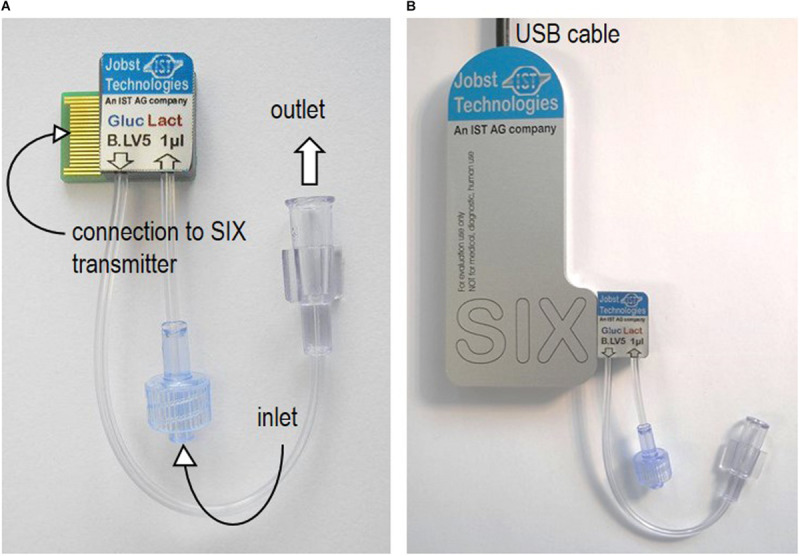
Biosensor platform. (A) The biosensor chip B.LV5 designed as a flow-through-cell with connection to the SIX transmitter and luer fittings as connections for inlet and outlet. (B) The biosensor connected to the SIX transmitter.